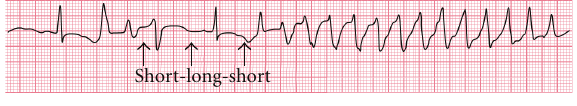
precursor to TdP [34]. T-wave alternans is thought to result from alternation of the M-cell APD, leading to exaggeration of transmural dispersion of repolarization during alternate beats, and thus the potential for development of TdP